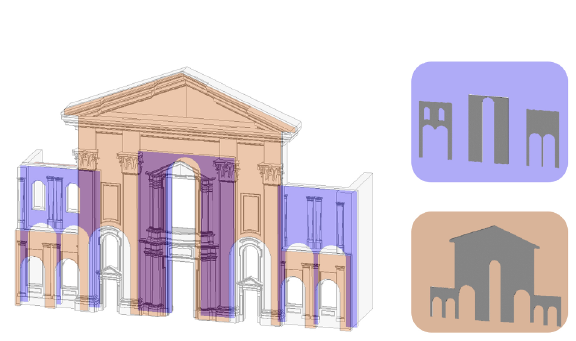
Figure 8. Graphical explanation of the composition of the fac¸ade model: two structural walls and one architectural wall with all the decorative